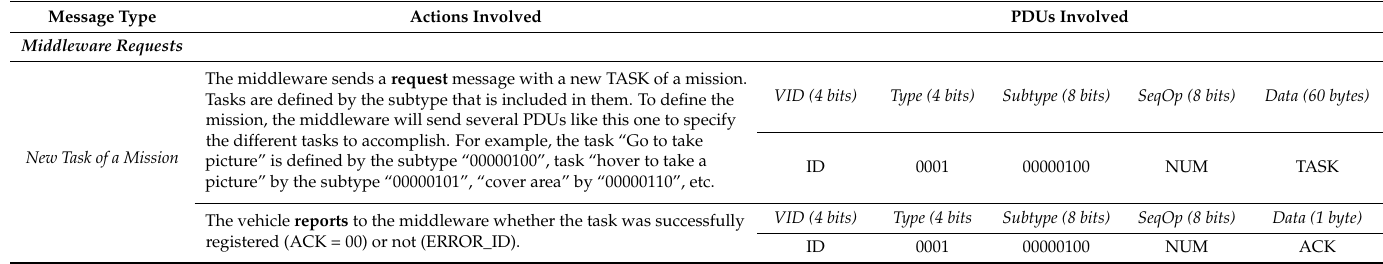
Figure 5. MDTP generic PDU. Table 4. Serialized data for overwater communications.